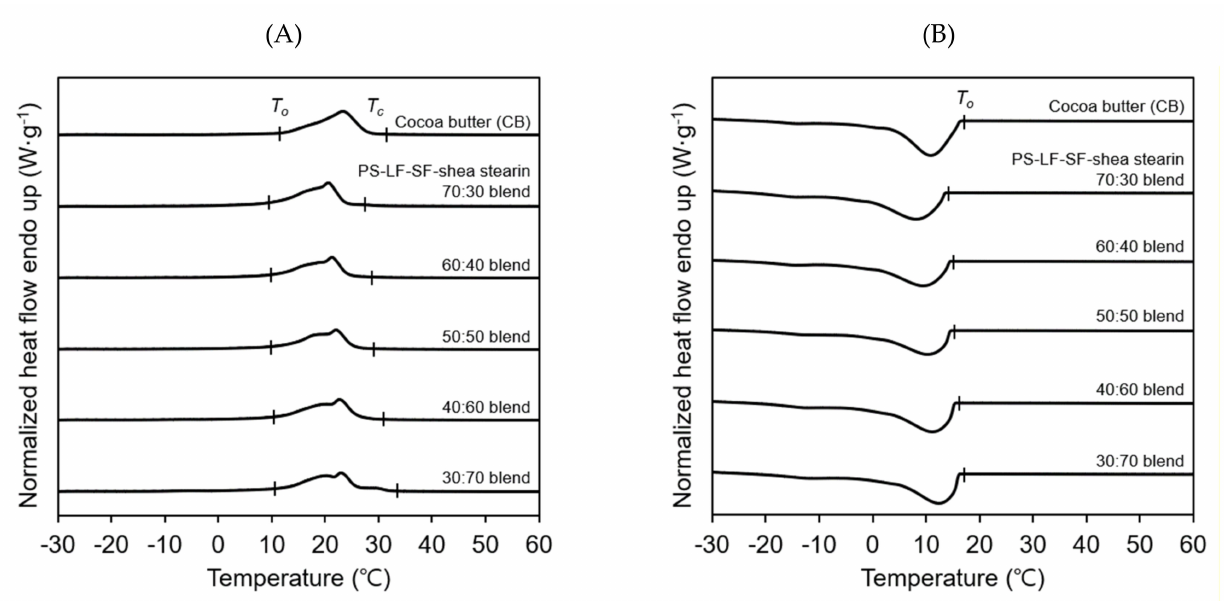
Figure 5. DSC melting ( A ) and crystallization ( B ) profiles of PS-LF-SF (POP-rich fats obtained by two-step hexane fractionation of palm stearin under the best conditions established in this study)–shea stearin (SOS-rich fats obtained by hexane fractionation of degummed shea butter under the best conditions optimized herein) blends with different PS-LF-SF:shea stearin weight ratios ranging from 70:30 to 30:70. T o and T c represent the onset and completion temperatures of melting or crystallization,